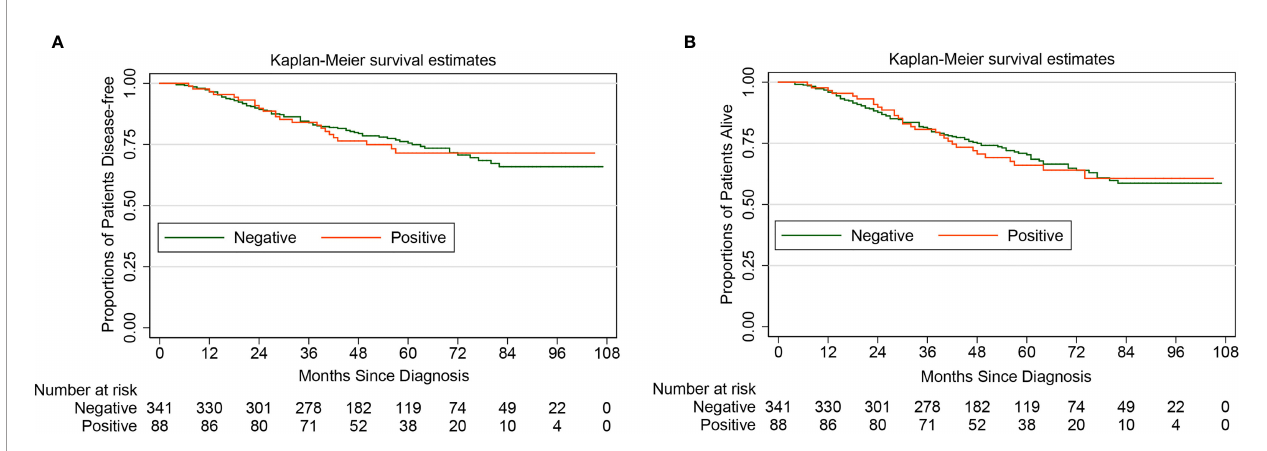
FIGURE 3 | Kaplan-Meier curves of disease-free survival and overall survival for patients with apparent early-stage type II endometrial cancer, by peritoneal cytology. ( A for disease-free survival; B for overall